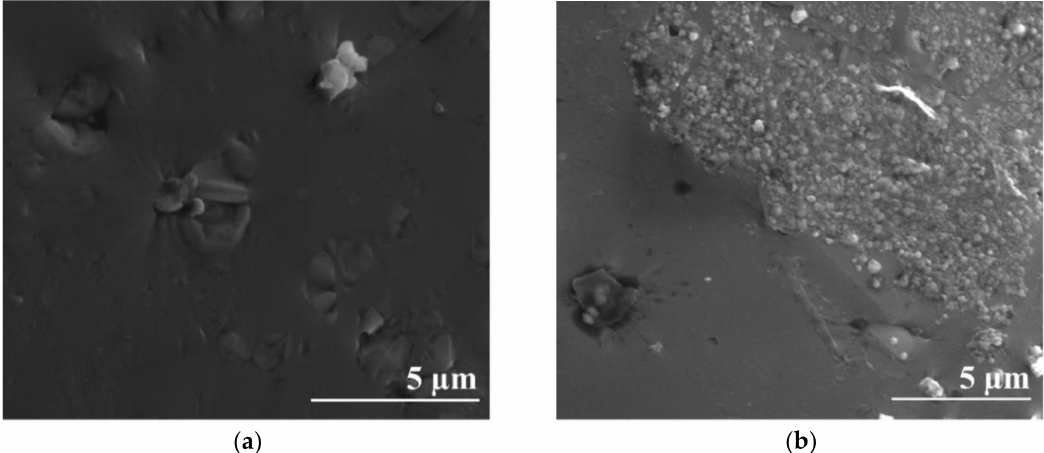
Figure 3. Scanning electron microscope (SEM) images of Ga-In (50:50 wt%), ( a ) fresh (unexposed to plasma), ( b ) spent (exposed to N 2 -H 2